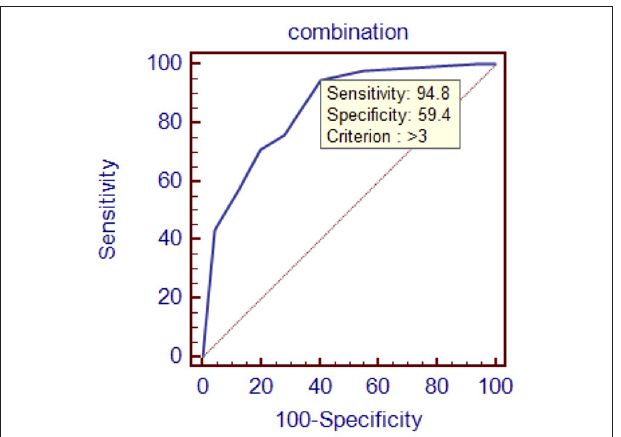
FIGURE 4 | Receiver operating characteristic curve of galectin-3 combined with interventricular septal thickness and E/A value. Area under the curve: 0.850, 95% C.I. (0.792–0.898), P <